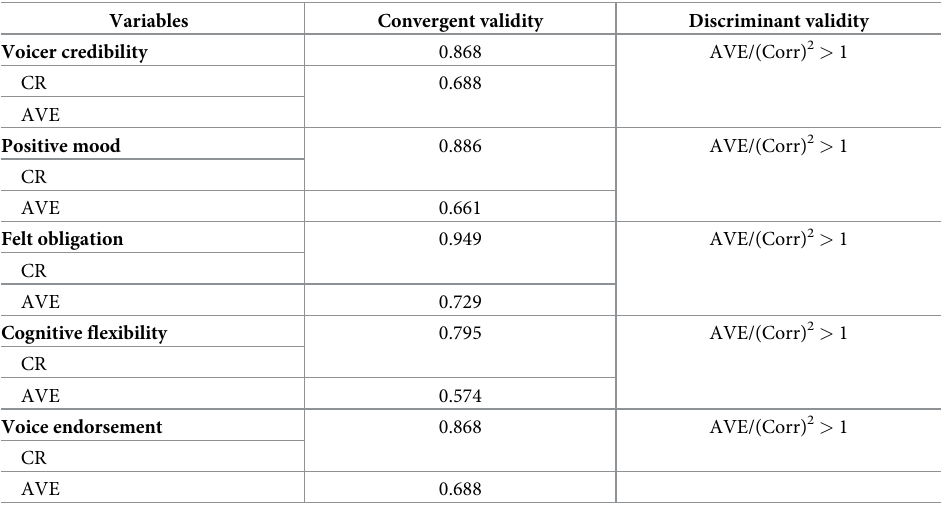
Table 3. Tests for convergent and discriminant